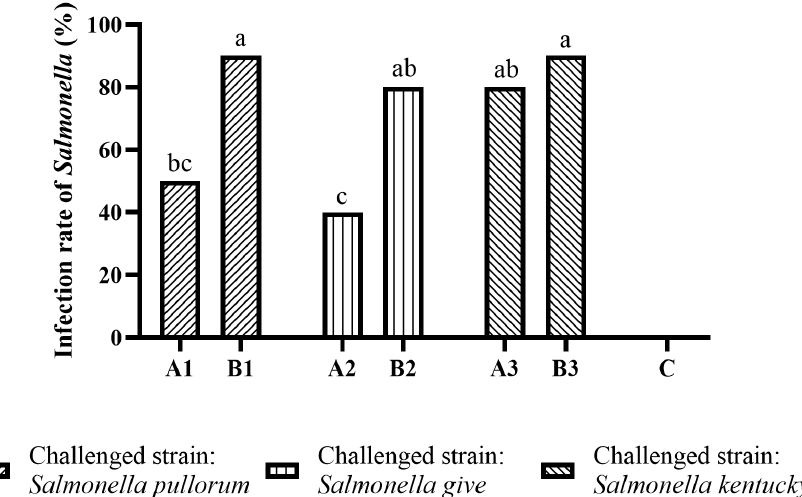
Figure 3. The infection rates of Salmonella in the birds in the Salmonella Pullorum , Salmonella Give , and Salmonella Kentucky -challenged groups. The means with different letters denote a significant difference ( p < 0.05) .